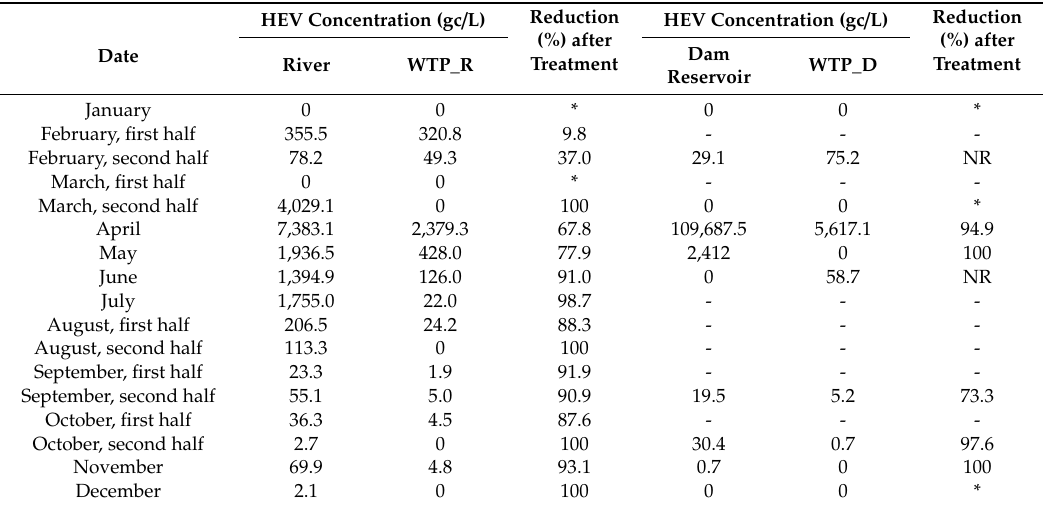
Table 2. Quantification of HEV RNA in concentrated samples from surface water sources and their associated water treatment plants, and evaluation of the treatment e ffi cacy (reduction in RNA copies). HEV Concentration (gc / L) Reduction HEV Concentration (gc / L) Reduction (%) after (%) after Date Treatment TreatmentRiver